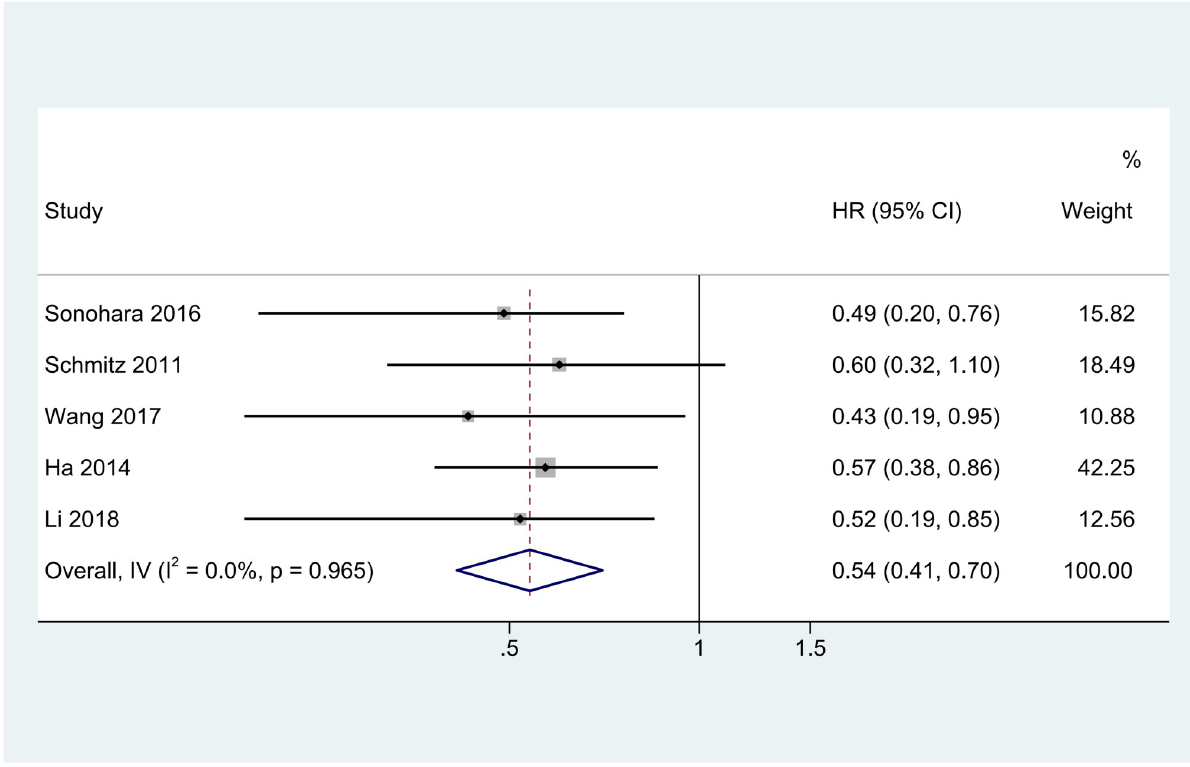
Fig 5. Forest plot of the HR for the association between high AKR1B10 expression and overall survival in patients after hepatectomy.